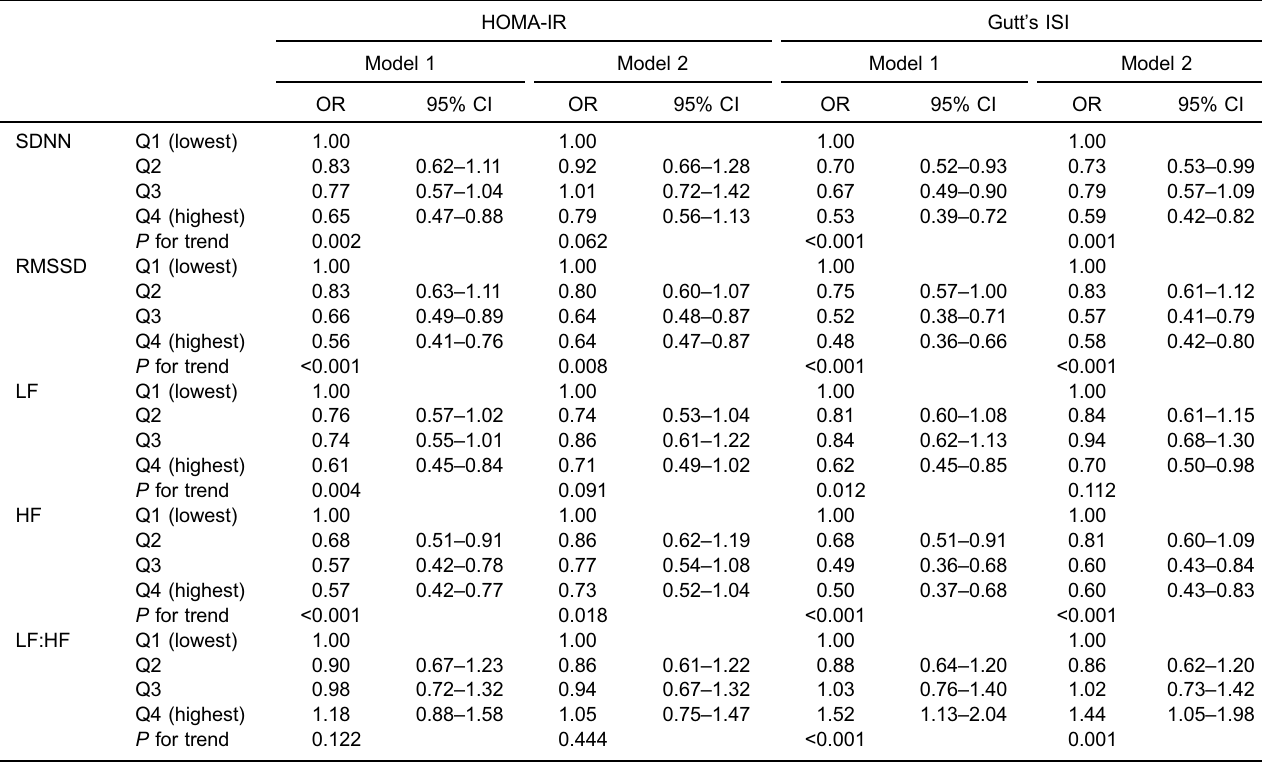
Table 3. Multivariable-adjusted odds ratios for elevated HOMA-IR (highest quartile) or lowered ISI (lowest quartile), grouped according to quartiles of heart rate variability parameters ( n =